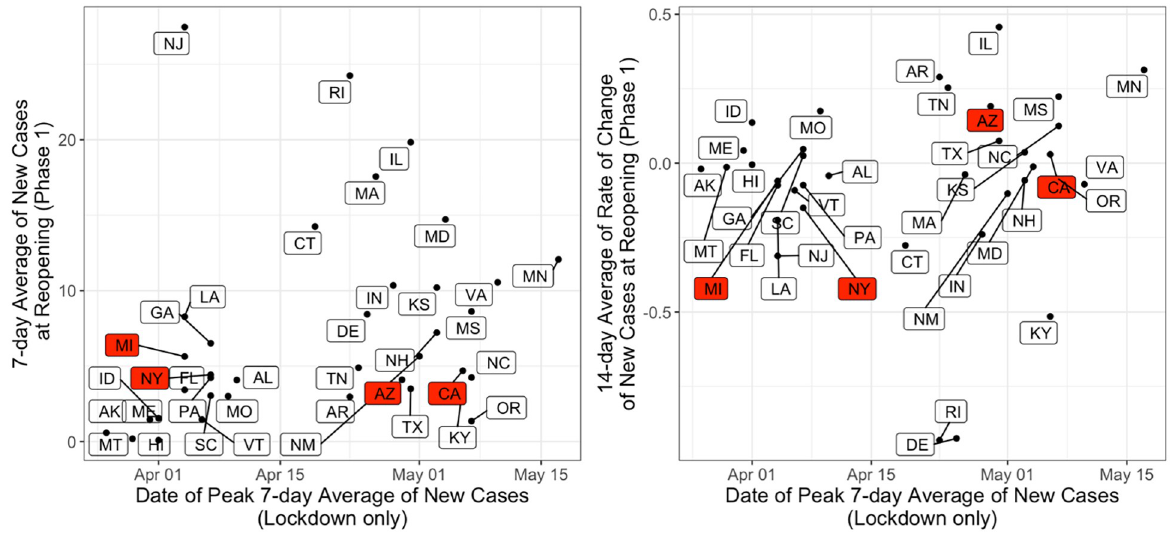
Fig 4. (A) 7-day average of COVID-19 incidence per 100,000 people at reopening to Phase 1 as a function of date of peak 7-day average of COVID-19 incidence per 100,000 people during the lockdown, for the states with phase information categorized. (B) 7-day average of rate of change of COVID-19 incidence per 100,000 people at reopening to Phase 1 as a function of date of peak 7-day average of COVID-19 incidence during the state